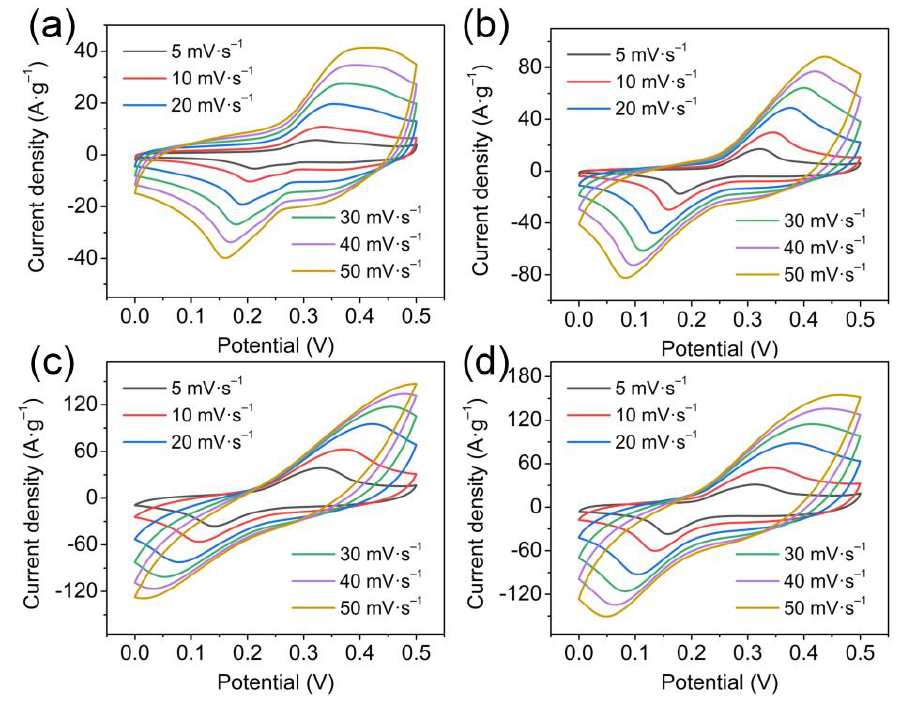
Figure 3. CV curves of ( a ) CoO x -110, ( b ) CoO x -120, ( c ) CoO x -130, and ( d ) CoO x -140 at various scan rates.